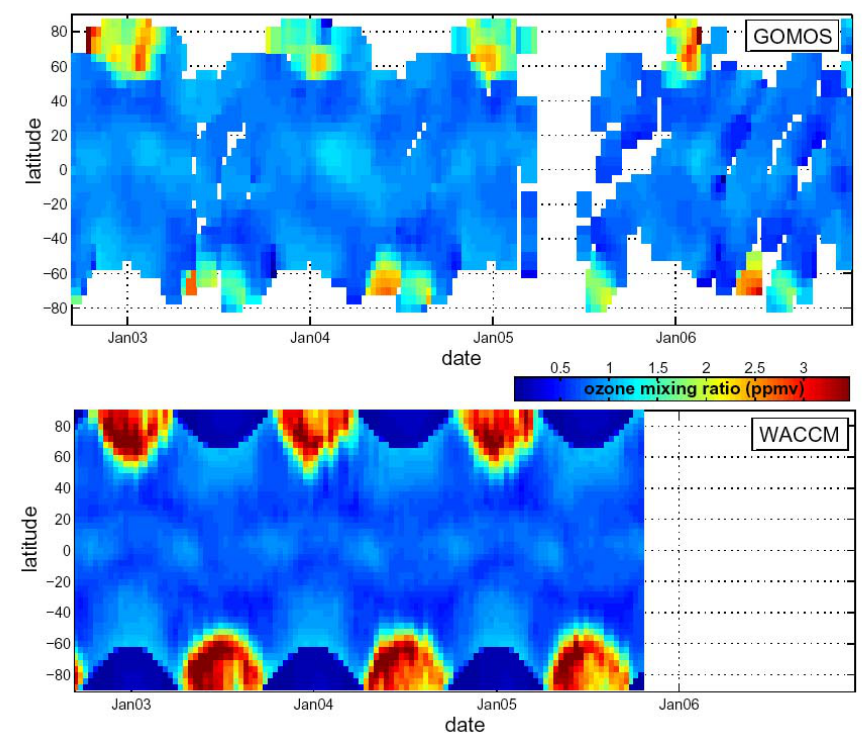
Fig. 29. Ozone mixing ratio at 72 km. Top: from GOMOS measurements (zonal mean), bottom: from WACCM simulations (mean over three ensemble simulations for 0 ° longitude, midnight). Temporal and latitudinal averaging is nearly the same for both experimental and model data (from Sofieva et al., 2009b).